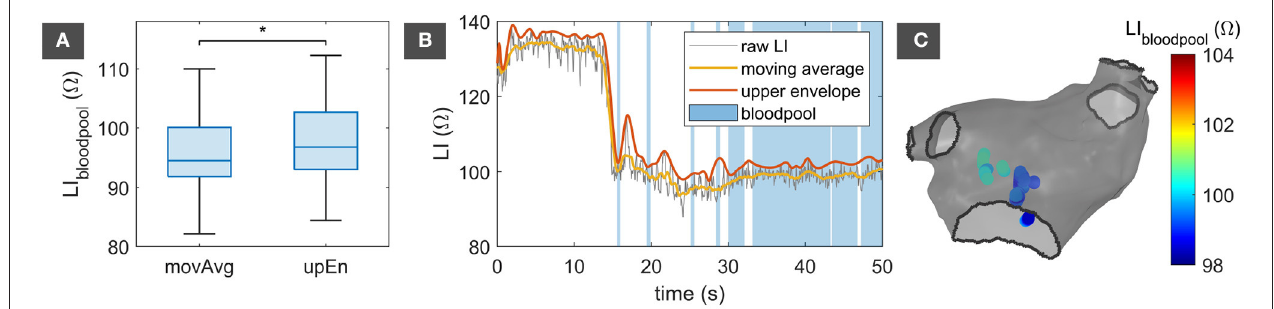
FIGURE 2 | Bloodpool reference impedance. (A) Distribution of LI bloodpool retrieved from LI movAvg and LI upEn for all 14 patients. The asterisk (*) denotes statistically significant difference between the distributions. (B) Exemplary trace of LI raw with corresponding LI movAvg and LI upEn . Samples with valid bloodpool acquisitions are marked in blue. (C) LA endocardial shell with spatial location of valid bloodpool acquisitions. movAvg, moving average; upEn, upper envelope; LI, local impedance; LA, left atrium.